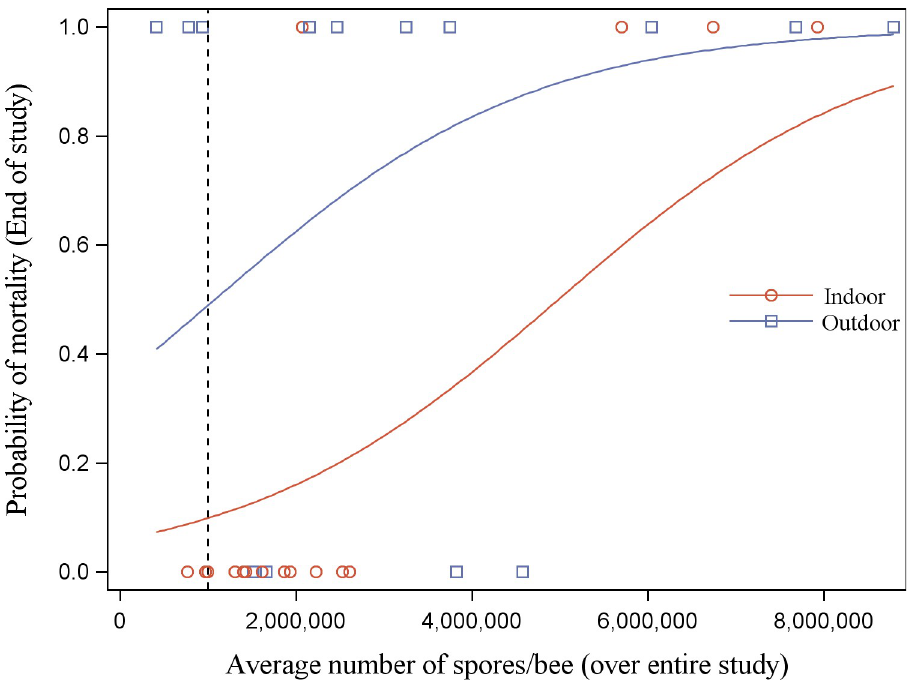
Fig 6. The effect of wintering method on the predicted probability of observing dead colonies at the end of 23 months (cumulative mortality at the end of the study) as influenced by the average Nosema abundance over the study (June 2017-September 2018). Indoor represents colonies moved to an indoor wintering building, and outdoor represents colonies kept outdoors in insulating wraps. Dashed line shows the 1 million spores/bee nominal threshold. The symbols indicate whether colonies were alive (0) or dead (1) at a specific Nosema abundance within wintering method. Samples of dead bees taken from the bottom board (due to the unavailability of live bees in the colony) are included in the